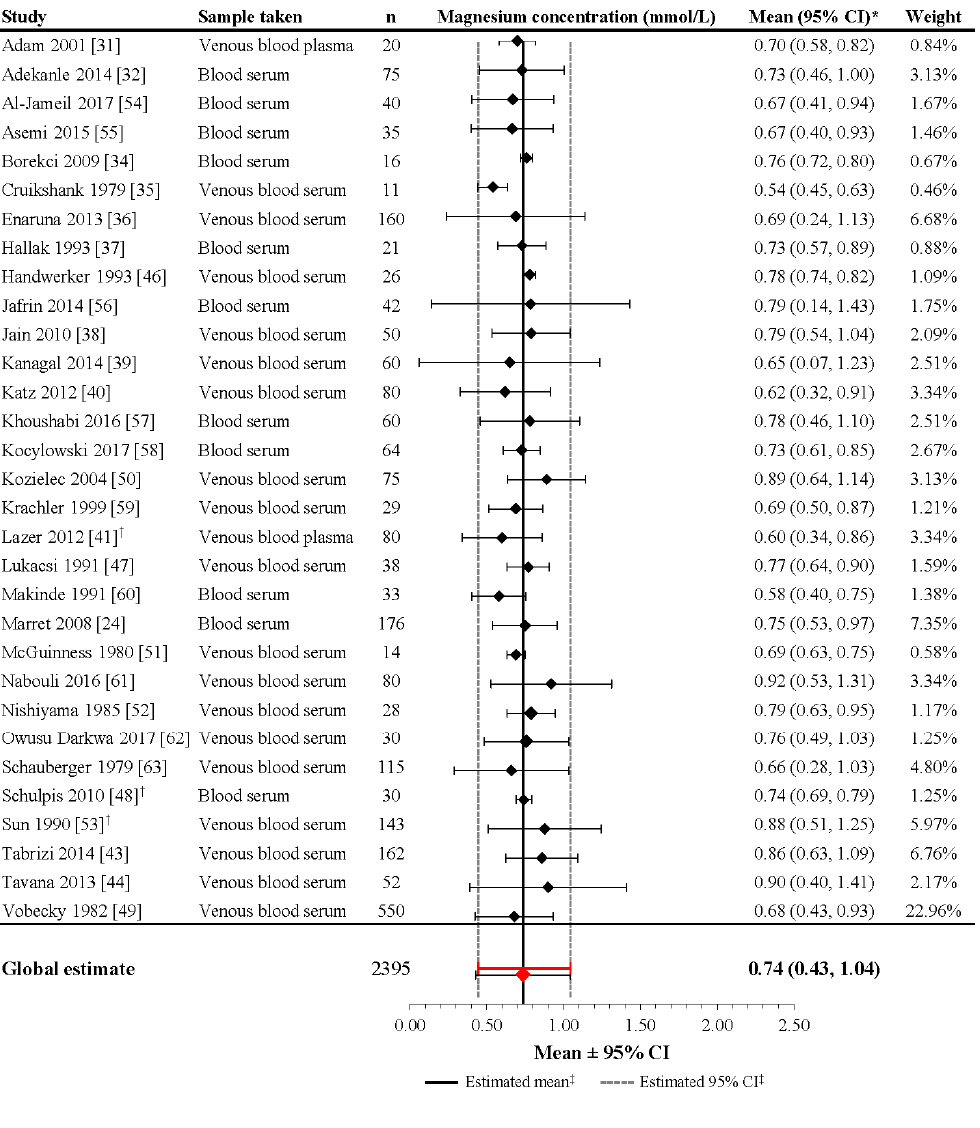
Figure 1. Magnesium concentrations in healthy pregnant women without magnesium supplementation during pregnancy. * If 95% CIs were not reported in the study, then the 95% CIs were calculated as follows: mean ± (1.96 × SD). † Patient groups within these studies were pooled, as the literature search did not confirm an association between magnesium levels and gestational age, birth weight, or mode of delivery. ‡ Reference line and 95% CI derived using only studies reporting both mean and SD data. Overall statistic for heterogeneity: I 2 = 97.8% ( p < 0.001). CI: confidence interval, SD: standard deviation.